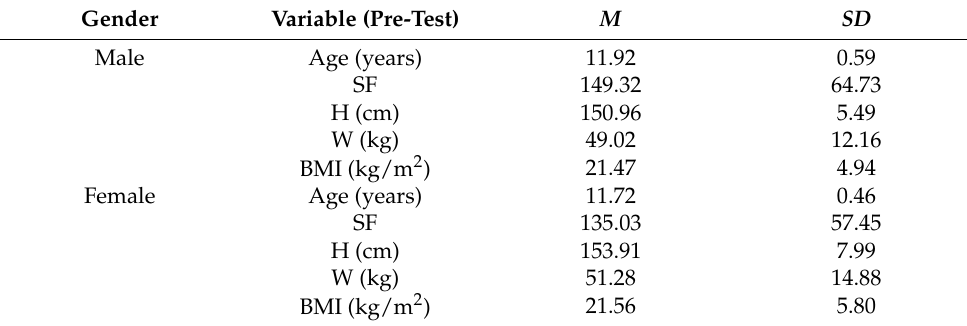
Table 1. Demographic and anthropometric data of participants at